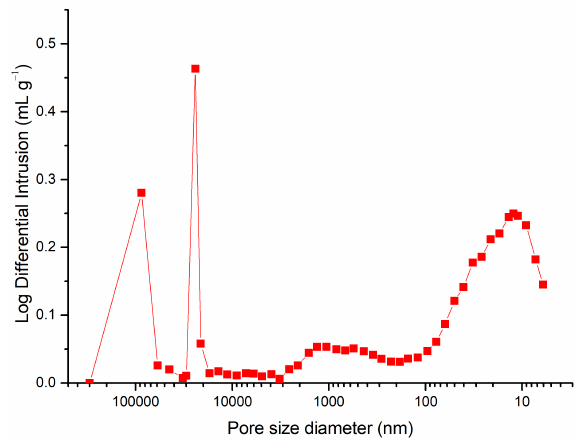
Figure 6. Log differential intrusion as a function of the pore diameter of the EOP biochar.